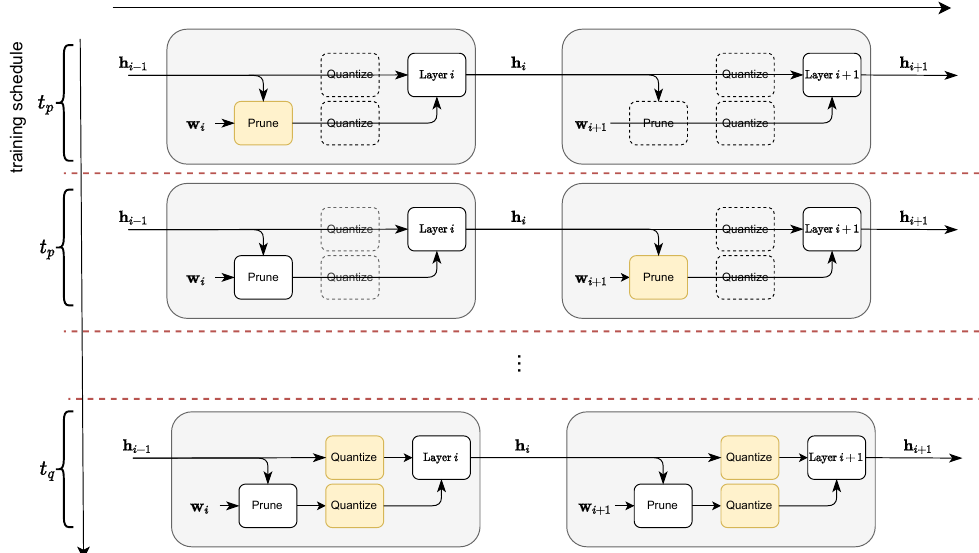
Figure 1. We introduce a joint layerwise channel pruning and uniform quantization framework built from algorithms formulated using moving average statistics. Here, yellow blocks denote operators actively being evaluated, clear blocks with dotted lines denote latent operators that have yet to be activated, and white blocks denote activated operators that have already been